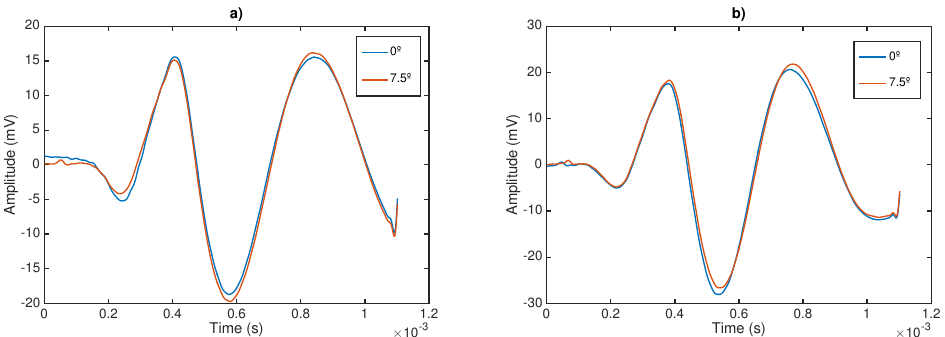
Figure 9. Measurement of shear wave speed at different angles of incidence sensor–phantom; frequency: 300 Hz. ( a ) 8% gelatin; ( b ) 10% gelatin.